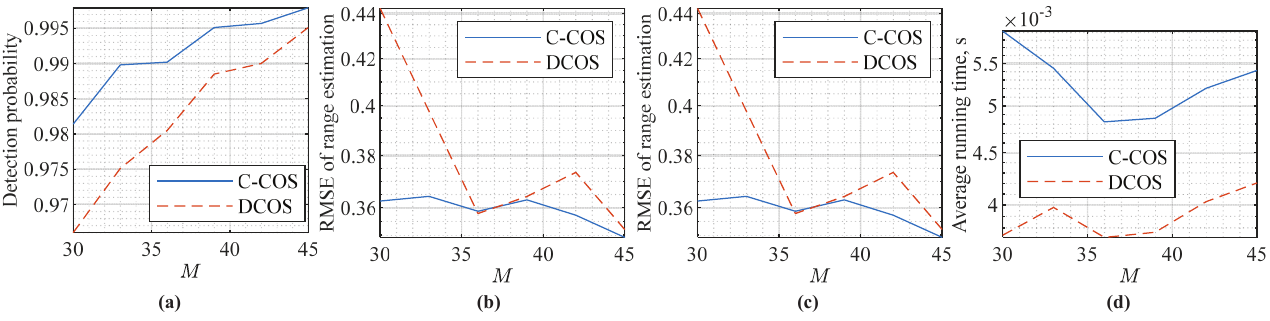
Figure 10. Comparing C-COS and DCOS in terms of detection and estimation performances, where the OFDM parameters are given in Table 3, and a single unit-power target is set here with range and velocity randomly generated over 10 4 independent trials. ( a ) illustrates the detection probability of the two methods under 10 − 4 false-alarm rate and γ = − 60 dB. ( b , c ) illustrates the range and velocity estimation performance, respectively, where the estimation method [48] is employed for both parameters. ( d ) compares the wall-clock time per run, including RDM generation, detection and estimation, for the two methods, as averaged over 10 4